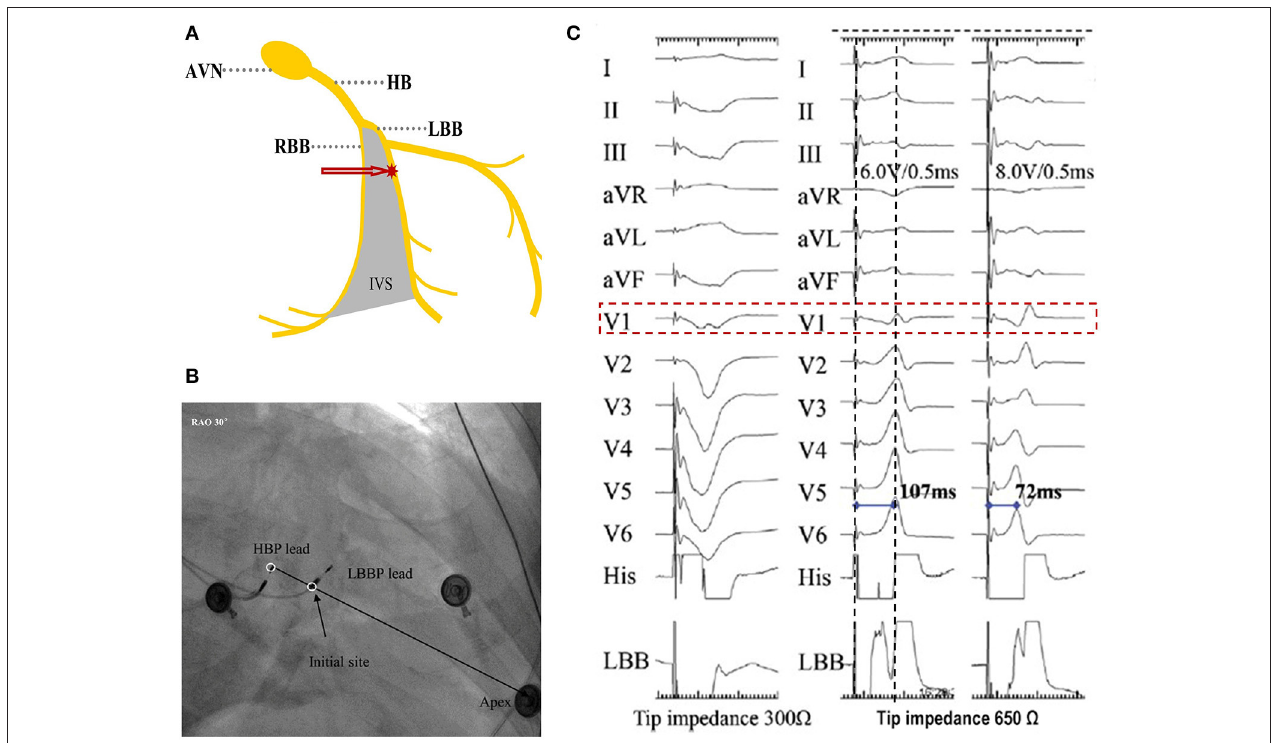
FIGURE 3 | How to locate the site for LBBP and electrogram characteristics. (A) A photographic representation of LBBP. (B) Location of the HBP lead and LBBP leads in the right anterior oblique 30 ◦ view. (C) Paced morphology of “W” pattern with a notch at the nadir of the QRS in lead V1 and impedance of 300 Ω by unipolar tip pacing before fixation (left). Screwing the lead ∼ 6–8mm deep, the notch in lead V1 moved up and toward the end of the QRS with impedance of 650 Ω . Increased output, from 6.0 V/0.5ms (middle) to 8.0 V/0.5ms (right), caused the paced morphology to change to RBBB and the pLVAT to be shortened from 107 to 72ms ( 9). HBP, His-bundle pacing; HB, His bundle; LBB, left bundle branch; LBBP, left bundle branch pacing; RBBB, right bundle branch block; pLVAT, peak left ventricular activation time; AVN, atrioventricular node; RBB, right bundle branch; IVS, interventricular